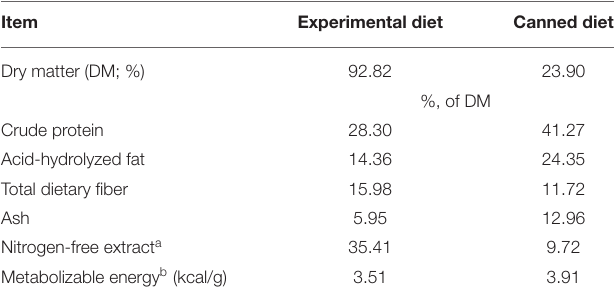
TABLE 2 | Analyzed chemical composition of the experimental diet and canned diet (CD) fed to yeast- or cellulose-supplemented dogs.